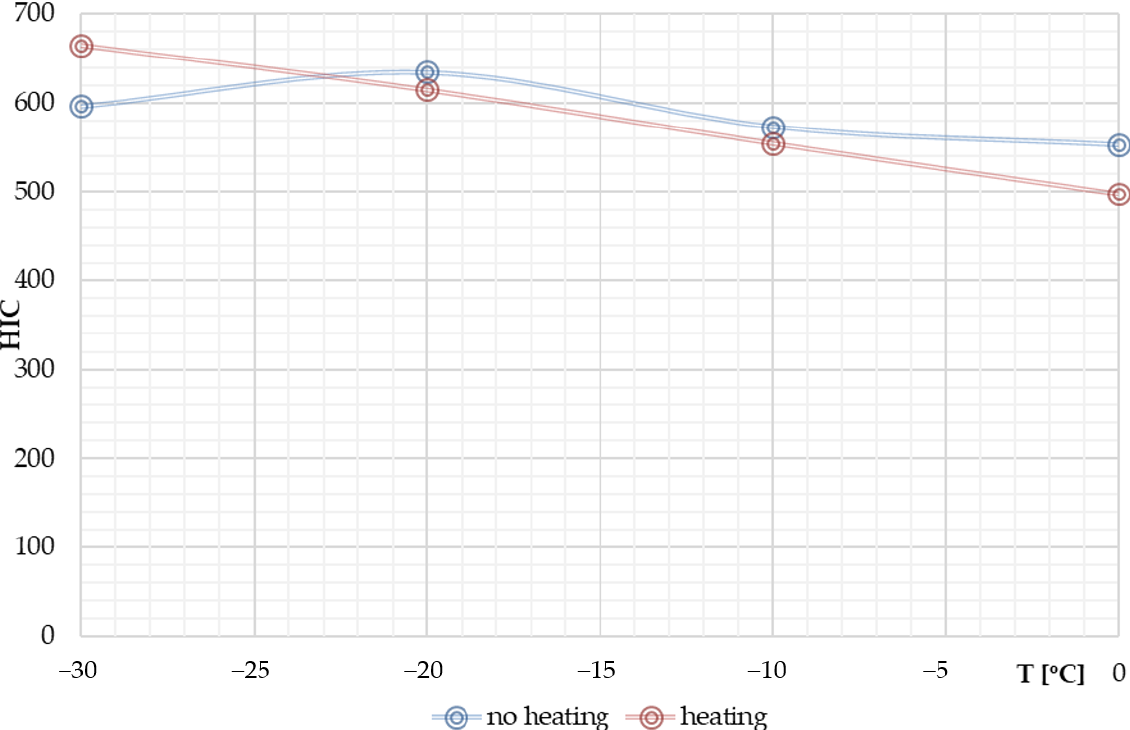
Figure 16. HIC for non-heated and heated windscreen.